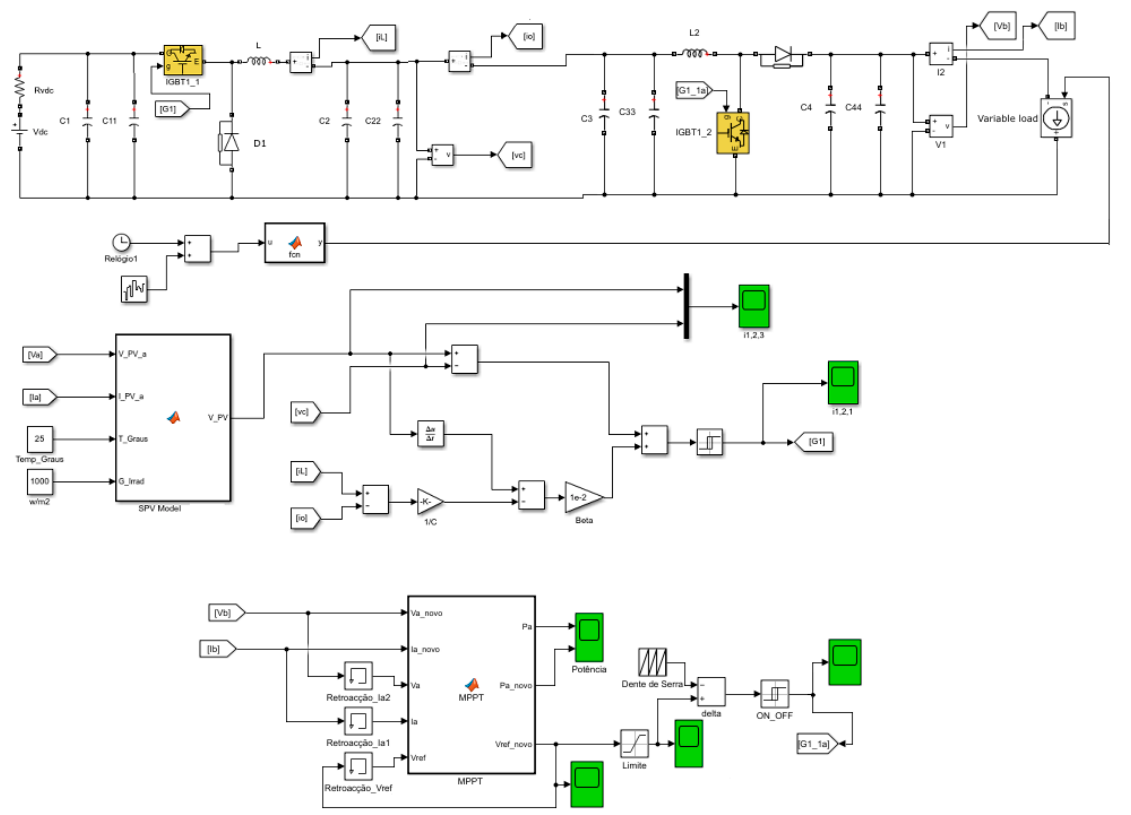
Figure 10. Matlab/Simulink model of the proposed simulator to test mode II.